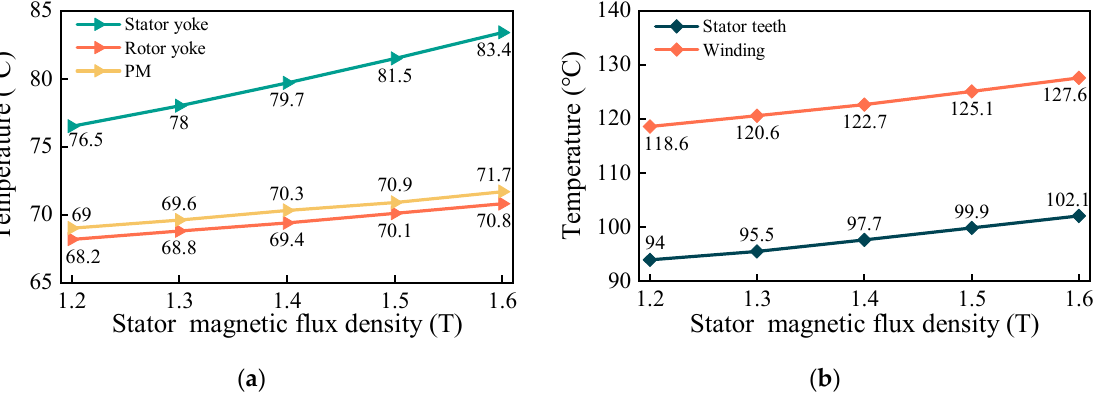
Figure 10. Temperature comparisons under different stator magnetic flux densities: ( a ) temperature comparisons of stator yoke, rotor yoke, and PM; ( b ) temperature comparisons of stator teeth and winding.